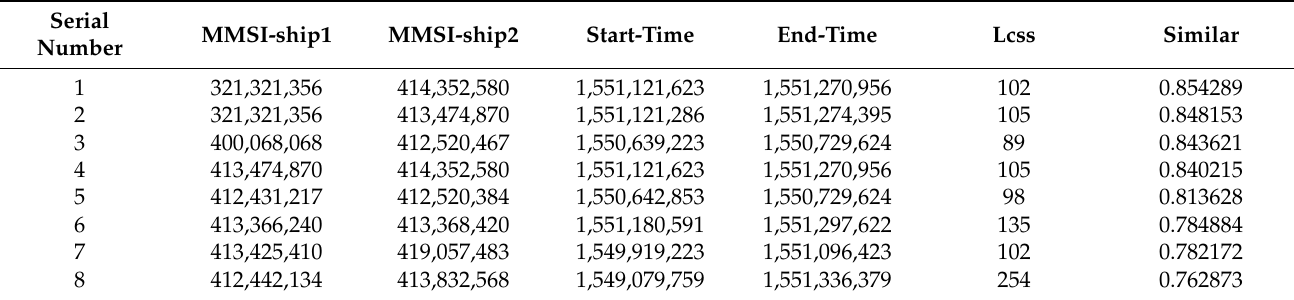
Table 3. STCP mining results.